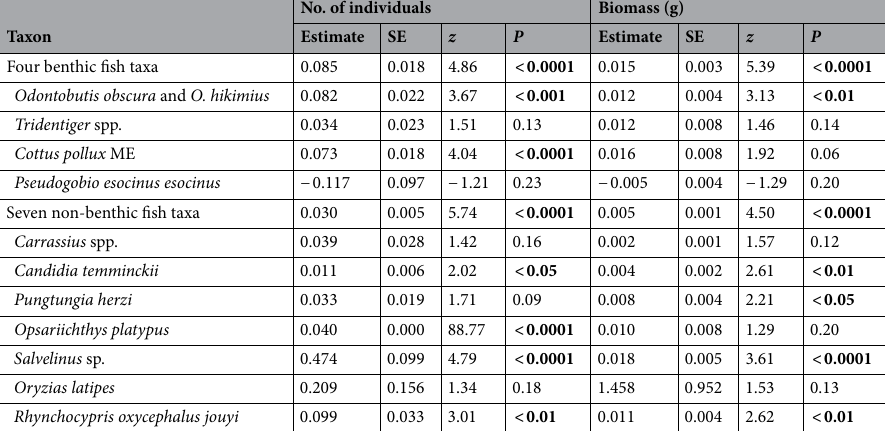
Table 1. Results of GLM for relationships between qMiSeq eDNA concentration (copies/L) and abundance or biomass for each taxon. Significant values are in bold. The scientific name basically followed Nakabo (2013), but Cottus sp. were denoted as Cottus pollux ME because it was known that Cottus sp. in the study sites have mitochondria sequences consistent with Cottus pollux ME regardless of morphology 72